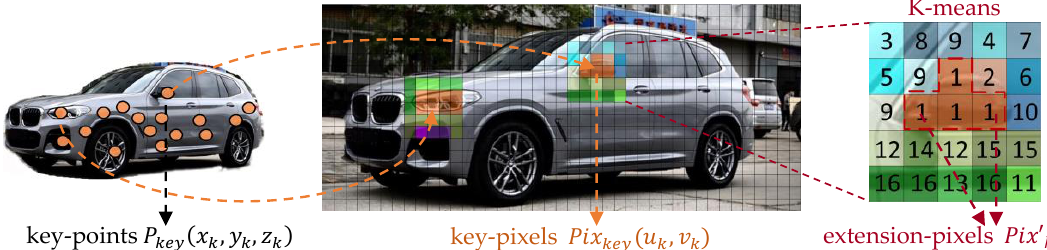
Figure 4. Illustration of target region A ∈ R ( d × d ) generation and K-means clustering process (region size d is 5 and the number of clusters is 16).